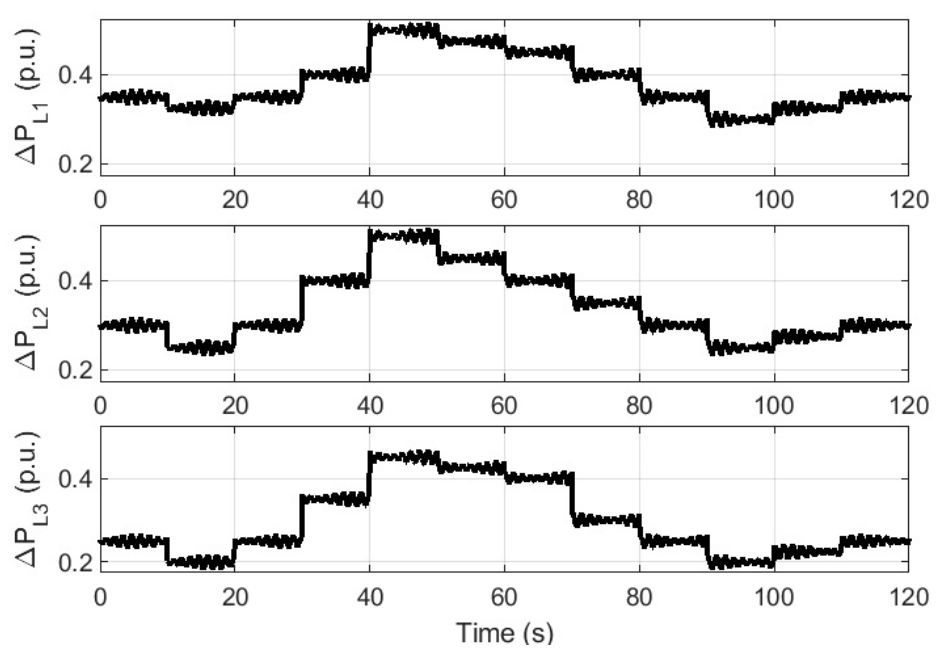
Figure 6. Loading pattern of 3 microgrids considering both LL and NL.